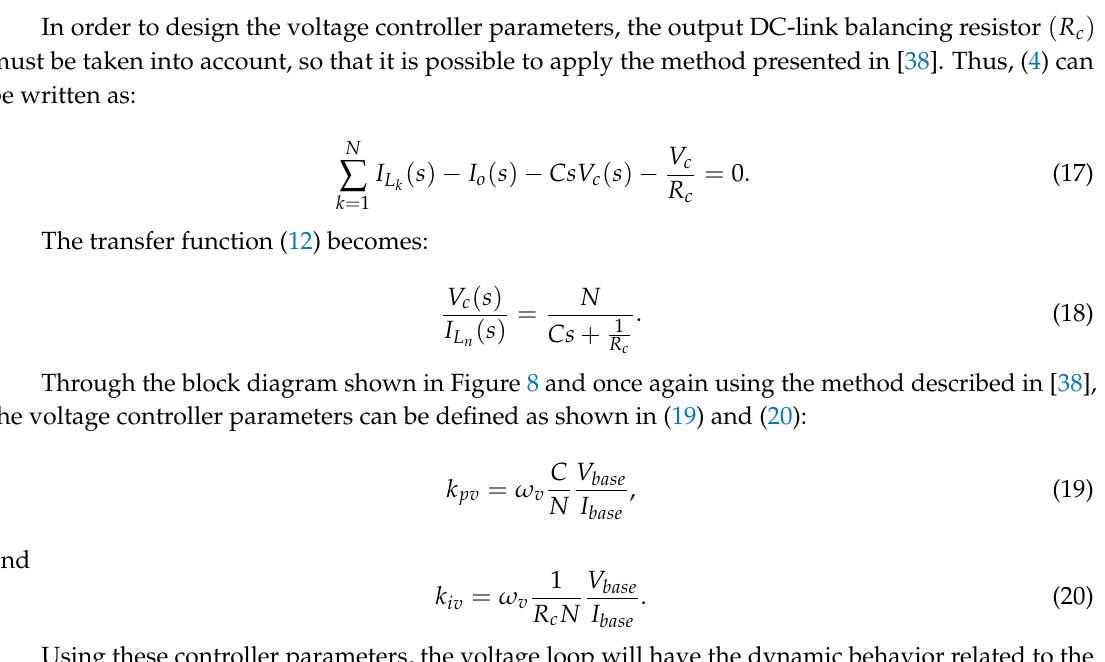
Figure 7. Difference between the designed bandwidth ( ω c ) and the actual obtained bandwidth (for the complete transfer function taking into account the poles and zeros that were neglected) for different values of